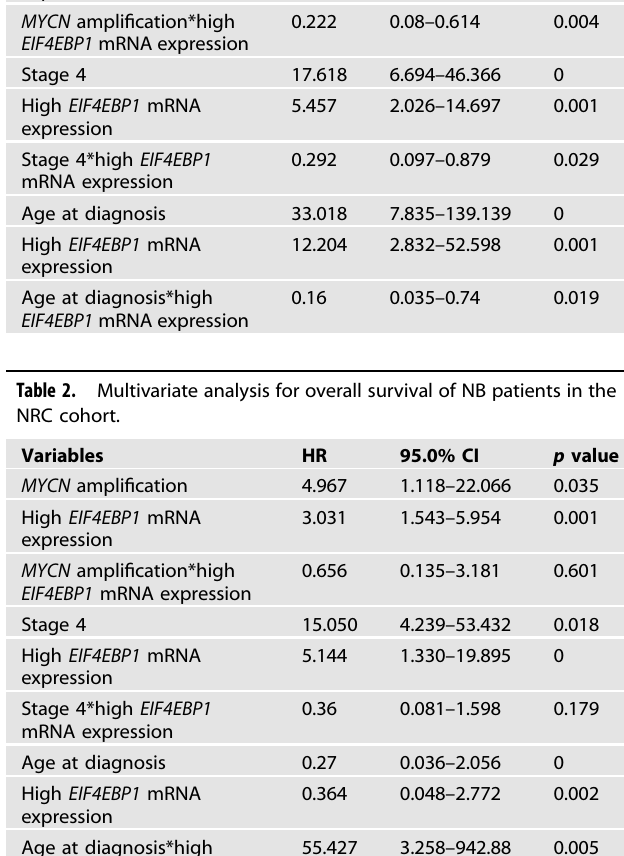
dependence of EIF4EBP1 expression as prognostic factor on EIF4EBP1 expression and MYCN ampli fi cation status, tumor stage